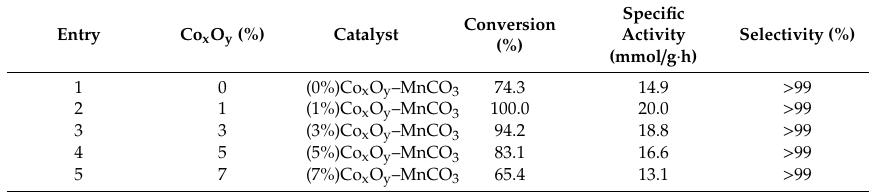
Table 2. Aerial oxidation of BzOH over the catalysts with varying % of Co x O y promoter.